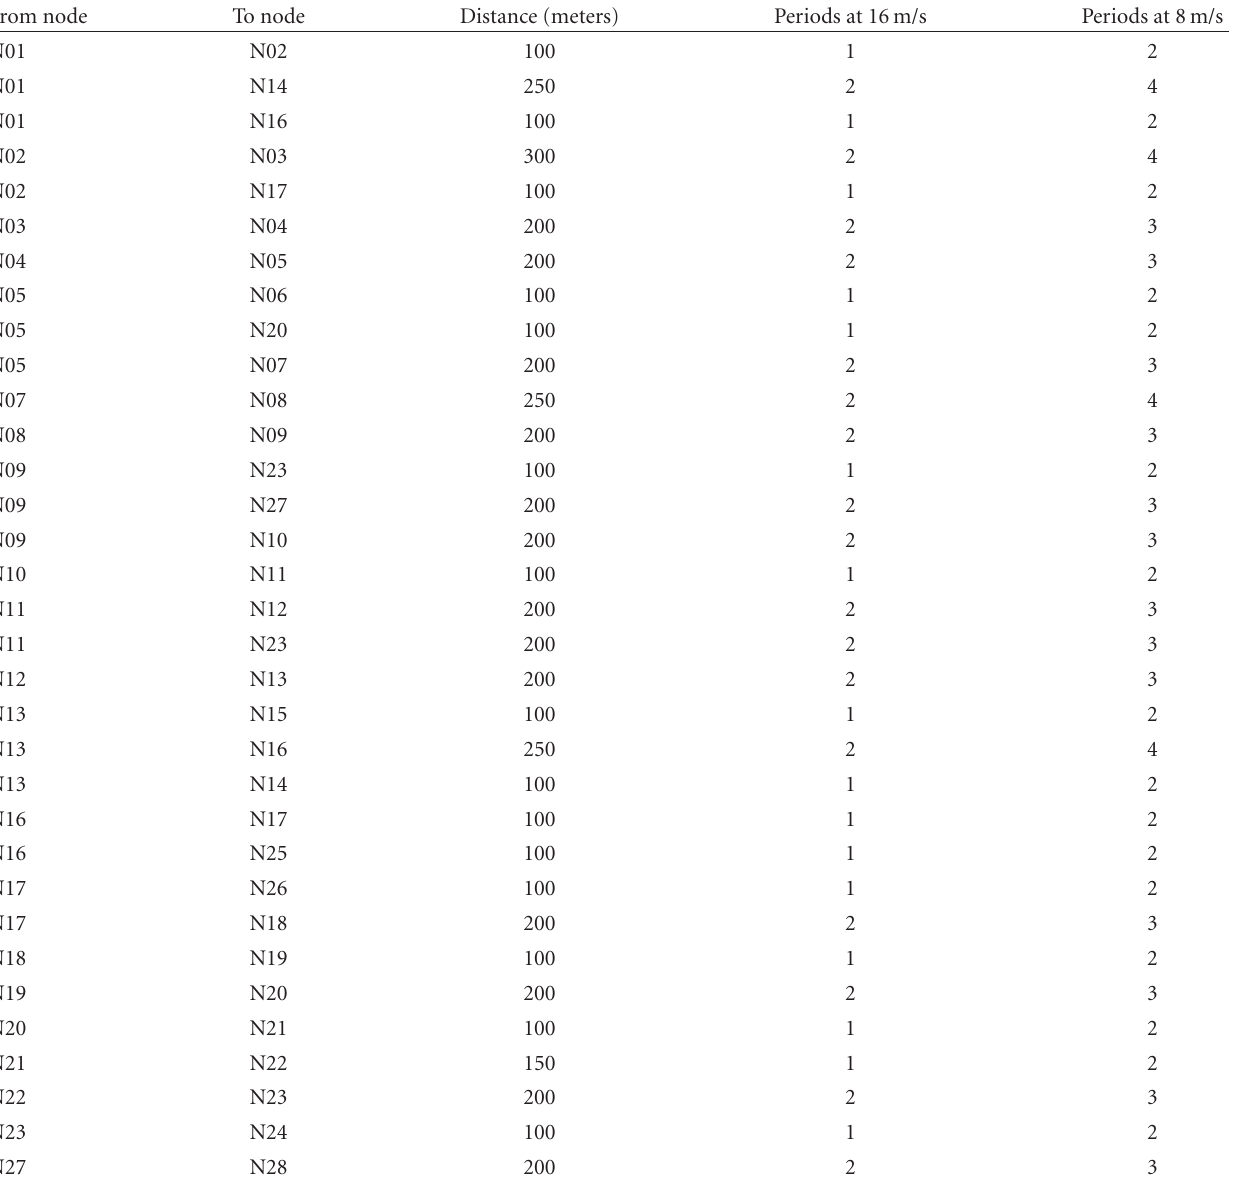
Table 1: The line element lengths and the number of periods needed to cover the elements with di ff erent taxi speeds. From node